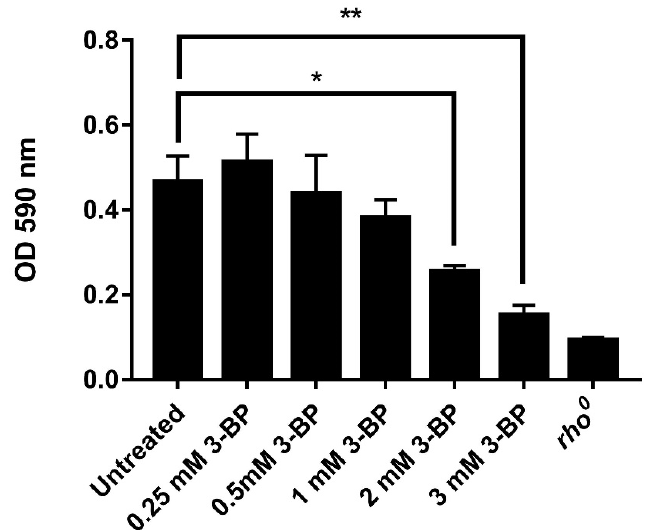
Figure 3. 3 ‐ BP leads to inhibition of mitochondrial activity in yeast. Logarithmically growing W303